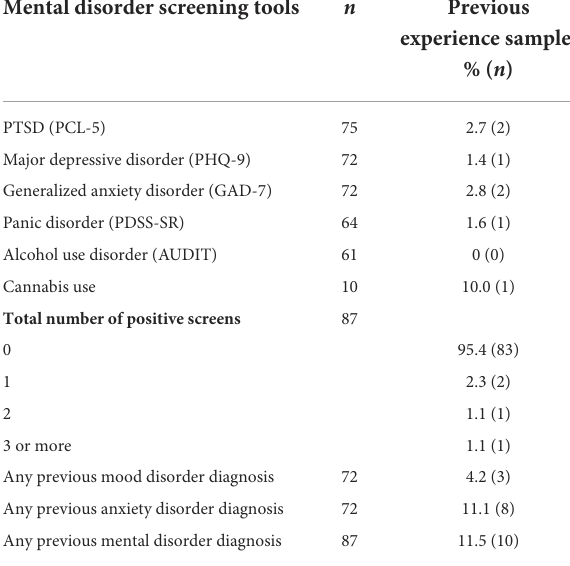
TABLE 3 Mental health disorders among participants with previous work experience in public safety, corrections, or armed forces. Mental disorder screening